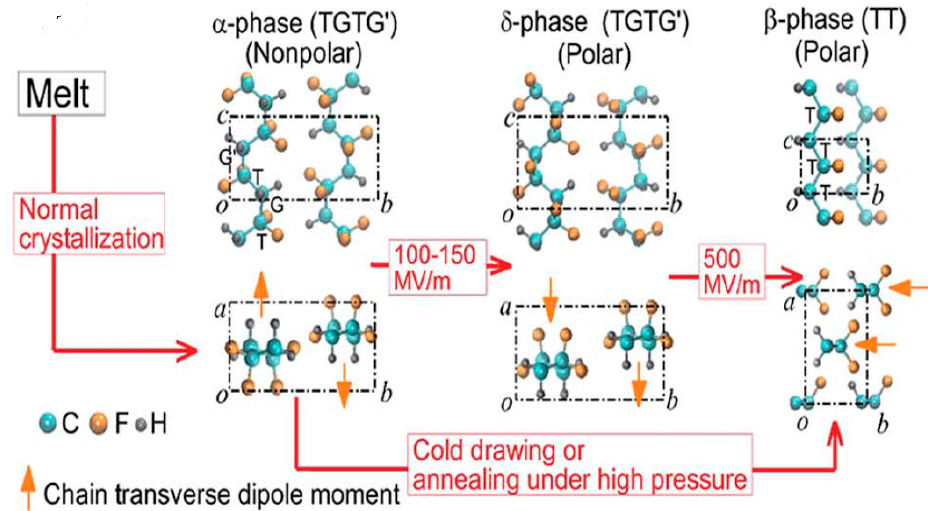
Figure 3. Electric field-induced phase transitions of PVDF. Electric poling aligns the dipoles along the electric field by applying a very high voltage. The transverse dipole moment of each polymer chain is shown using an orange arrow that points from the negatively charged fluorine atoms to the positively charged hydrogen atoms. T-trans; G-gauche. Reproduced with permission from [55], published by AIP Publishing, 2016.